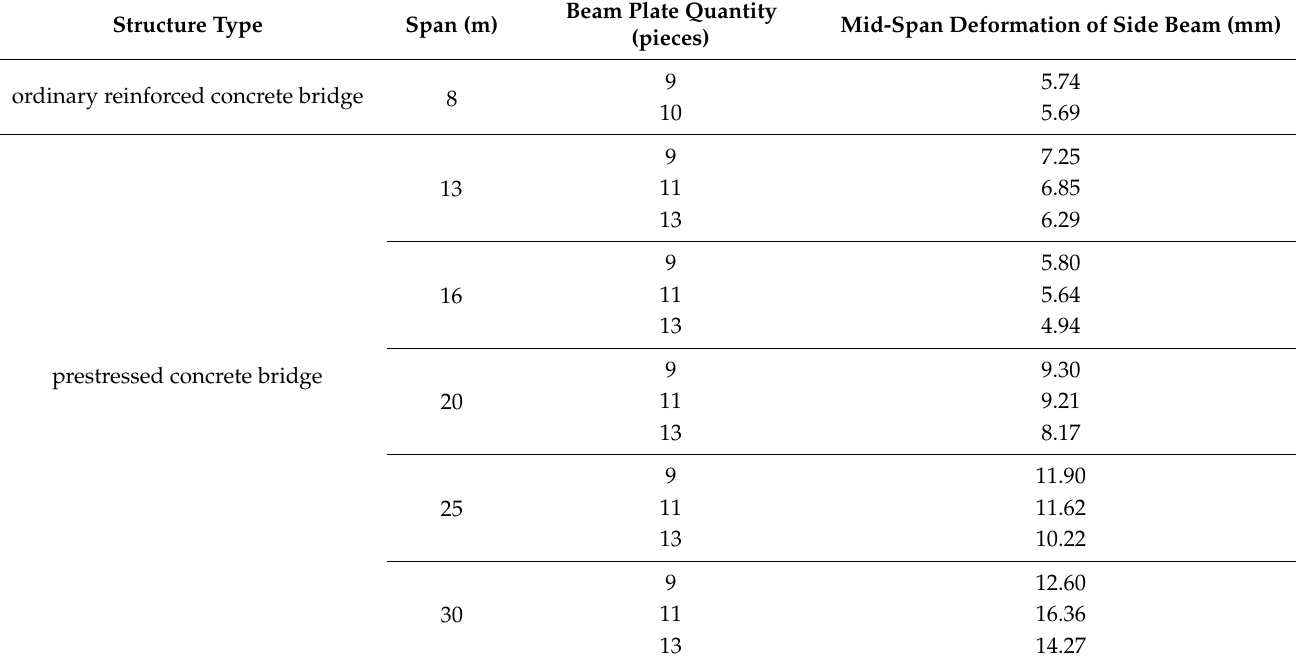
Table 5. Deformation of bridges under live loads on Pingli Highway.